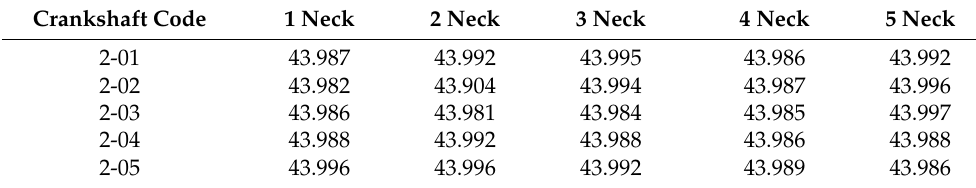
Table 3. Crankshaft main journal diameter (mm).